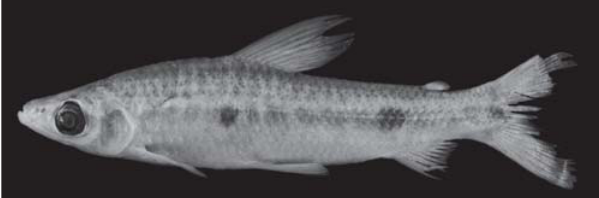
Fig. 22. Young specimen of Laemolyta proxima , MZUSP 27382, 92 mm SL; Brazil, Amazonas, Costa do Japão, Ressaca do Japão, lower rio